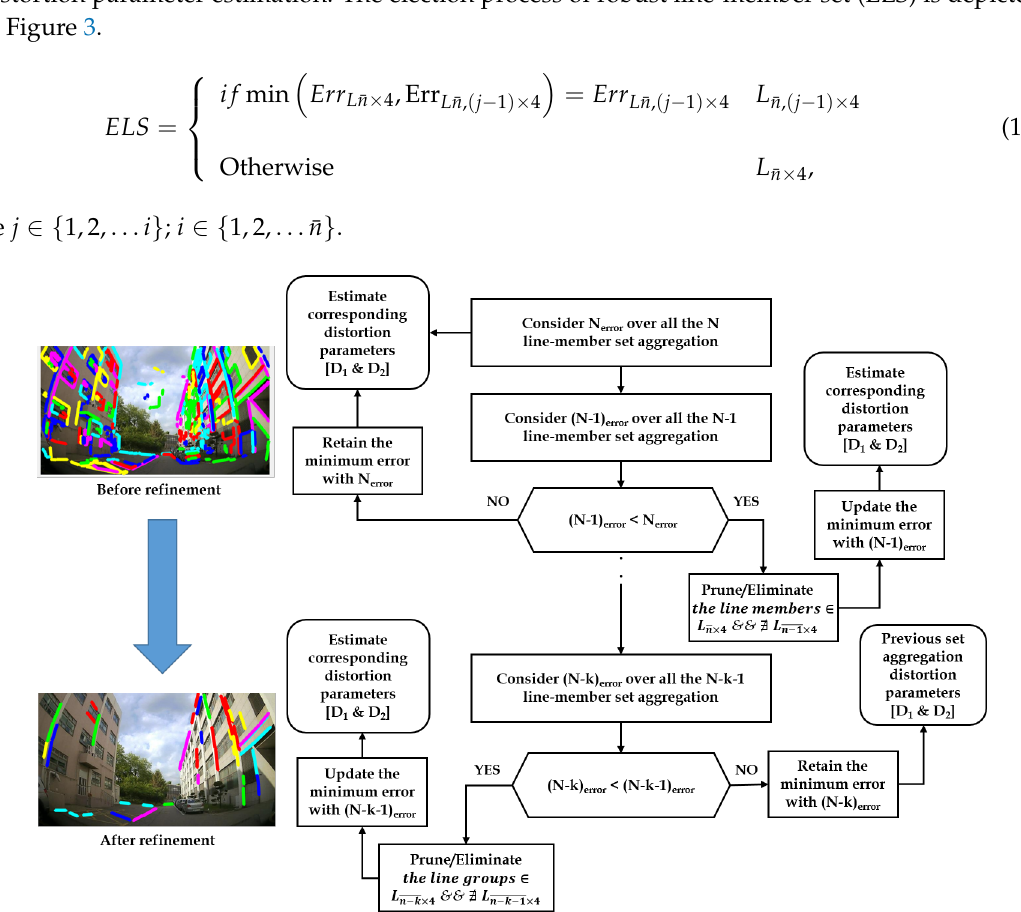
Figure 3. Outlier refinement scheme based on line-member set